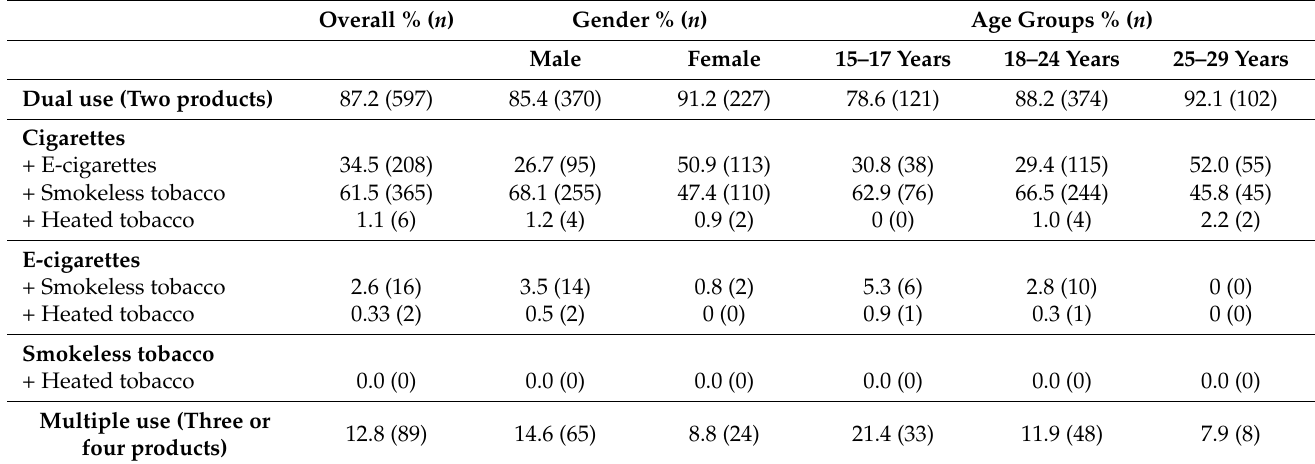
Table 4. Dual and multiple use of tobacco or nicotine-containing products.